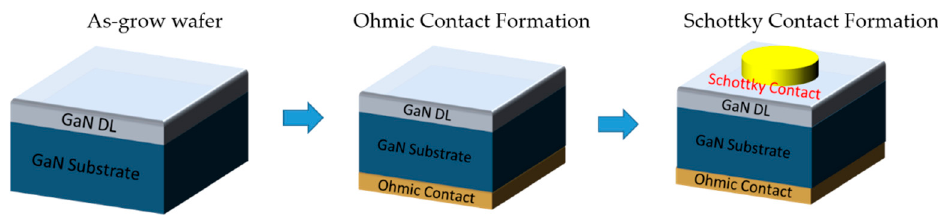
Figure 9. Fabrication of 1 mm GaN Schottky barrier diodes (SBD).